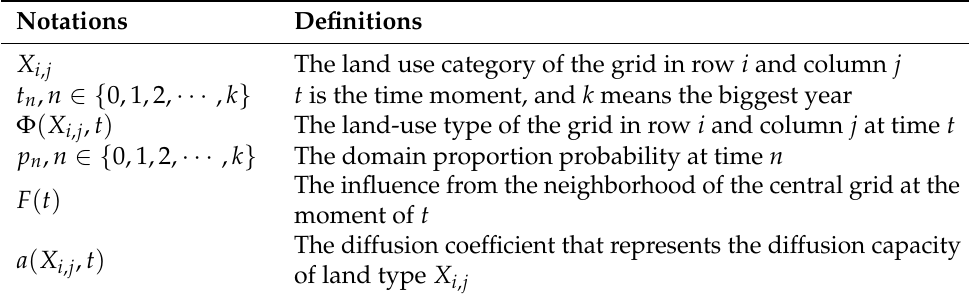
Figure 2. The definitions of the three types of neighborhoods. Table 1. The symbols used in this article and their